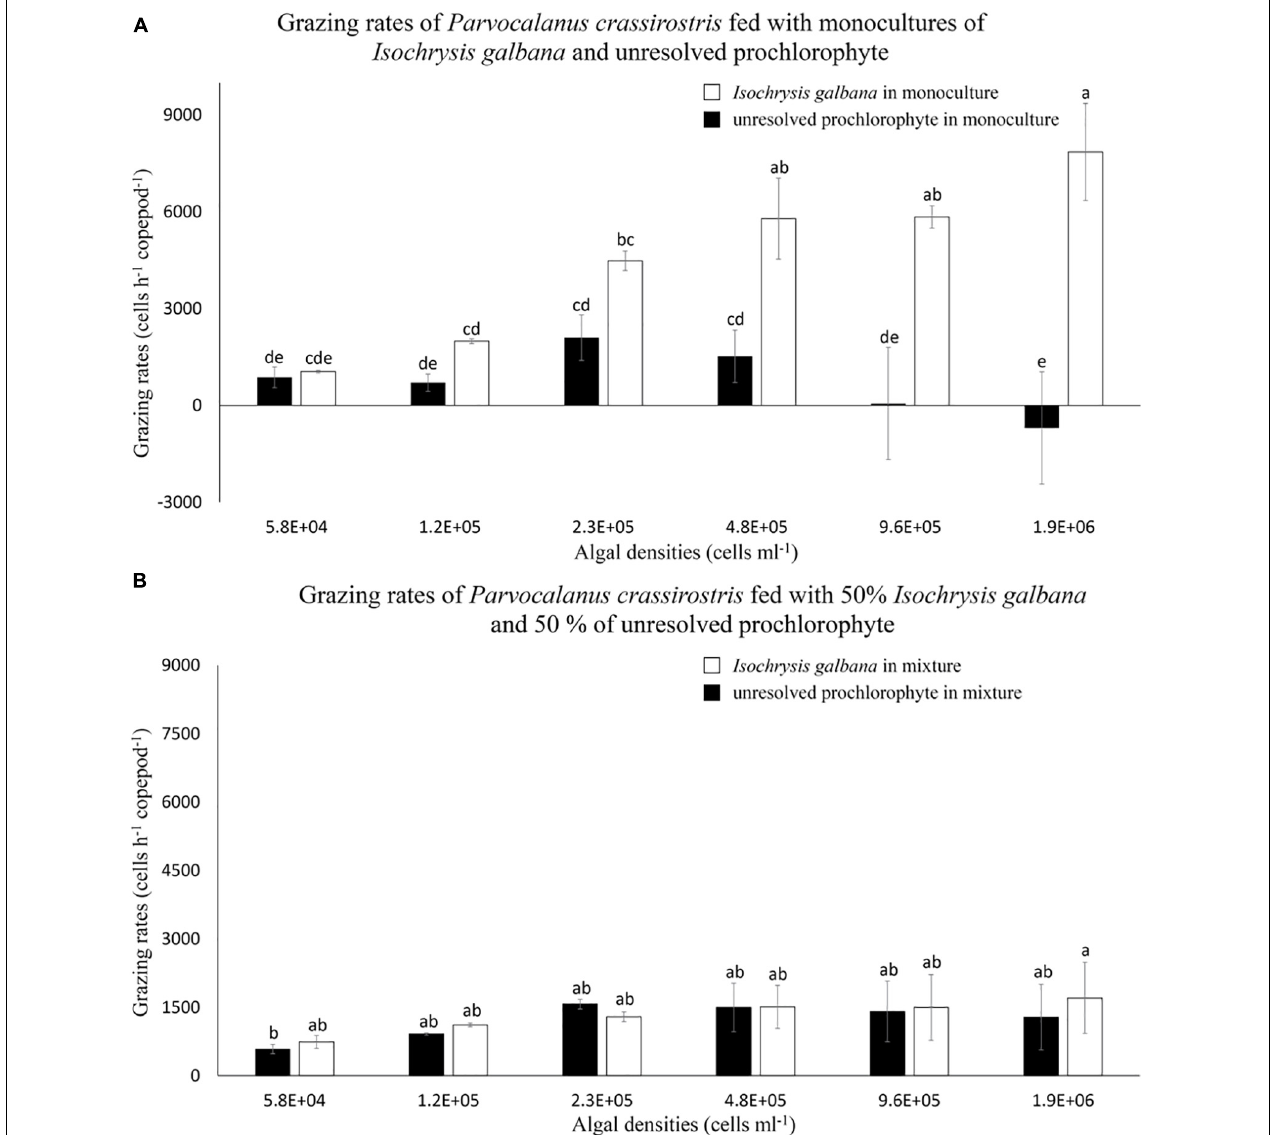
FIGURE 2 | Mean numbers of cells consumed per hour ( ± standard deviation, SD) by Parvocalanus crassirostris grazing on different densities of Isochrysis galbana and an unresolved prochlorophyte presented (A) as monocultures and (B) as mixtures of 50% I . galbana and 50% the prochlorophyte. Different letters identify significantly different means based on analysis of variance and Tukey’s post hoc pairwise comparisons ( α =